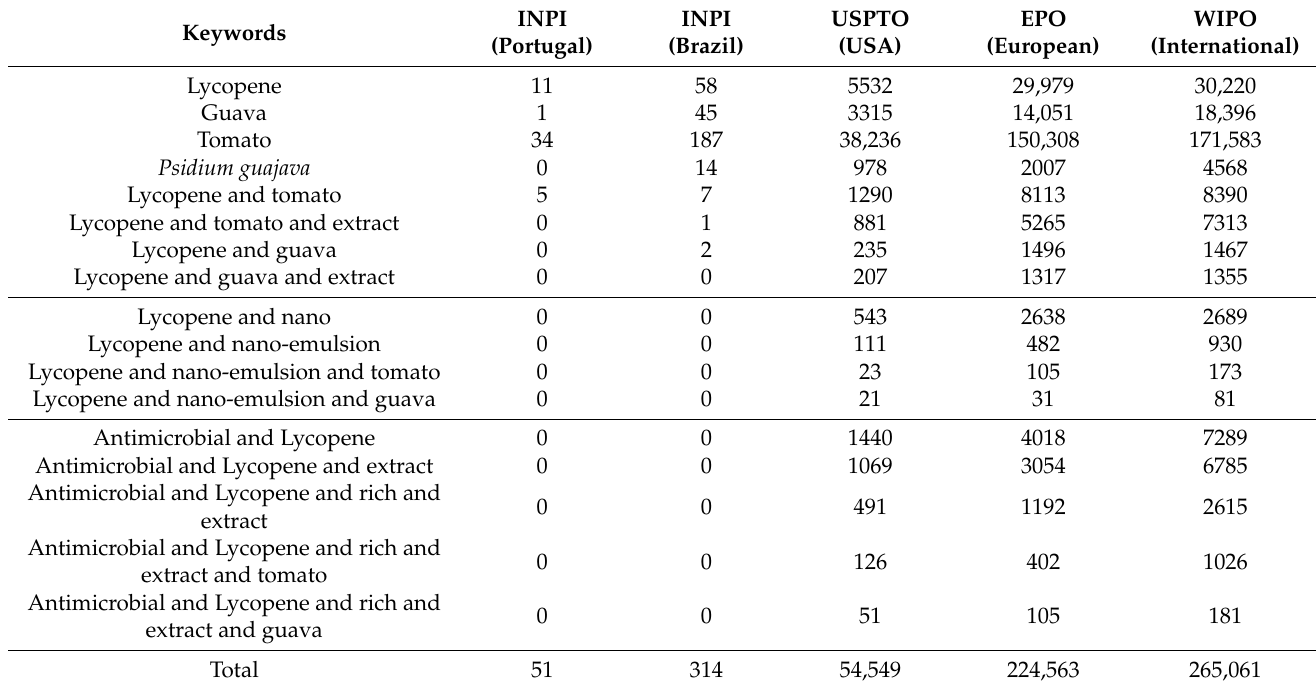
Table 5. Number of patents after search on INPI, EPO, USPTO, and WIPO databases (in columns) using the keywords inserted in Table 5